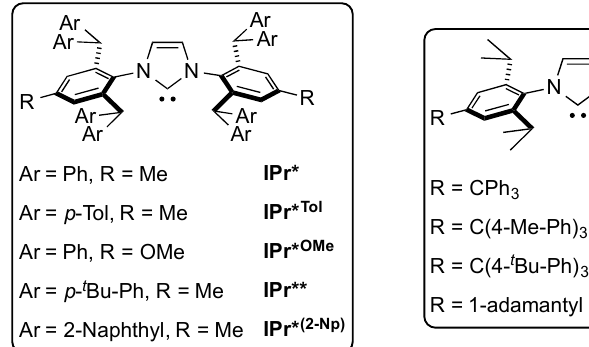
Figure 1. Structure of the IPr* , IPr + C and IPr CxHy ligands [28,61–64].